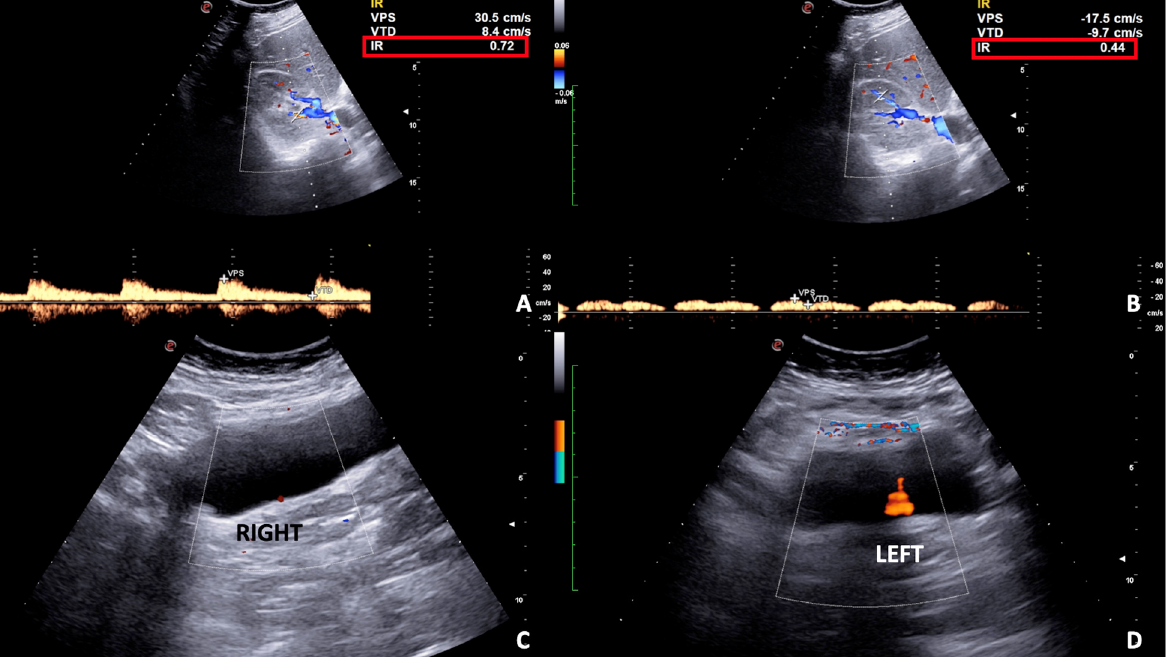
Figure 9. Spectral ( A , B ) and Color ( C , D ) Doppler scans of the right kidney and bladder in a pregnant woman with right flank and pelvic pain in incomplete urinary obstruction. ( A ) Mild hydronephrosis with no notable obstructive calculus is detected and the resistivity index is slightly increased on spectral Doppler ( A ) as well as the venous impedance index ( B ). ( C , D ) The ureteral jet is reduced on the right compared to the left side.